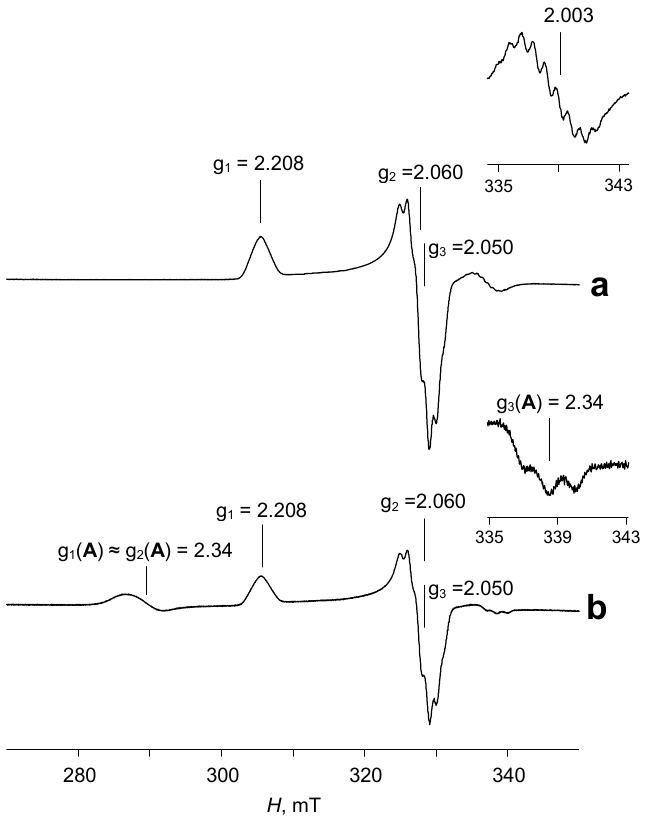
Figure 6. Frozen solution EPR spectra ( − 196 °C) of the samples: ( a ) L 2 Ni II Br 2 /MMAO (Al/Ni = 25, toluene, [Ni] = 10 mM), mixed and stored for 1 h at 25 °C; ( b ) sample in ( a ) after adding 600 equiv. of ethylene at − 70 °C.